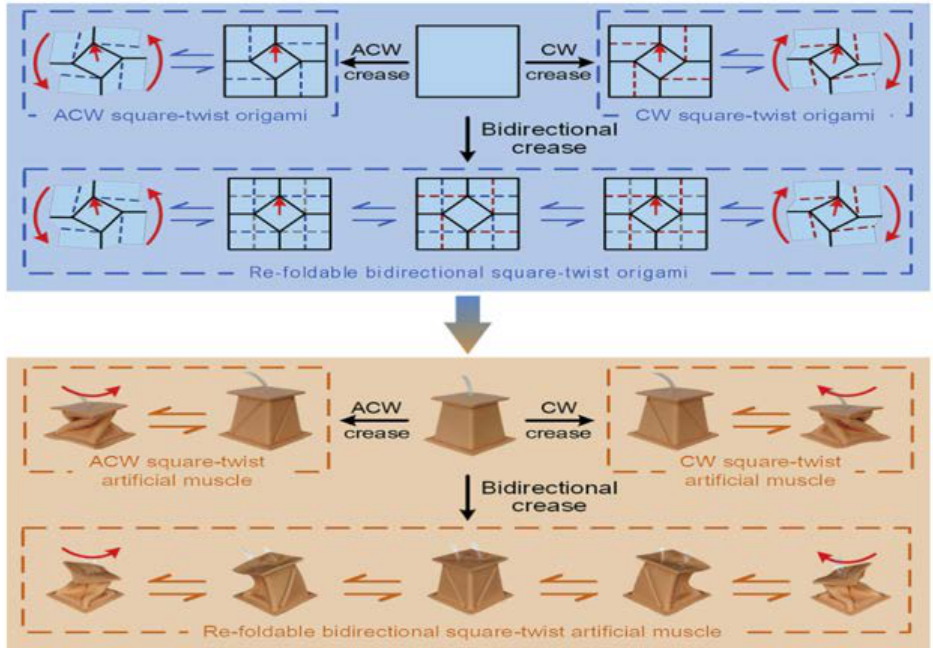
Figure 1. The counterclockwise ACW and clockwise CW square twist are actuated by a vacuum. The section is an overhead view of what direction the vacuum is actuating on the example piece, whereas the orange section is an isometric view of what happened on the example piece as a result of the vacuum’s actuation (Reprinted with permission from Jiao et al. [12]. Copyright 2021, CC BY NC ND 4.0 International).